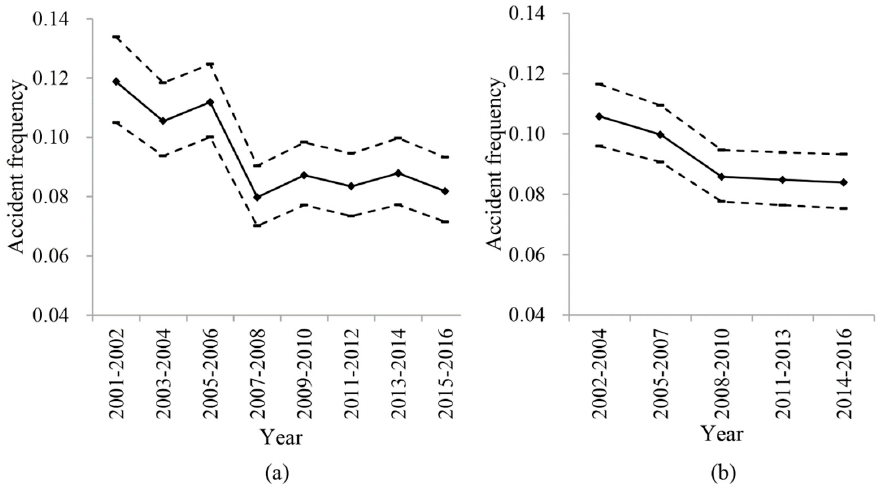
Figure 5. ( a ) Uncertain time series calculated by every two years of accident data; ( b ) Uncertain time series calculated by every three years of accident data.